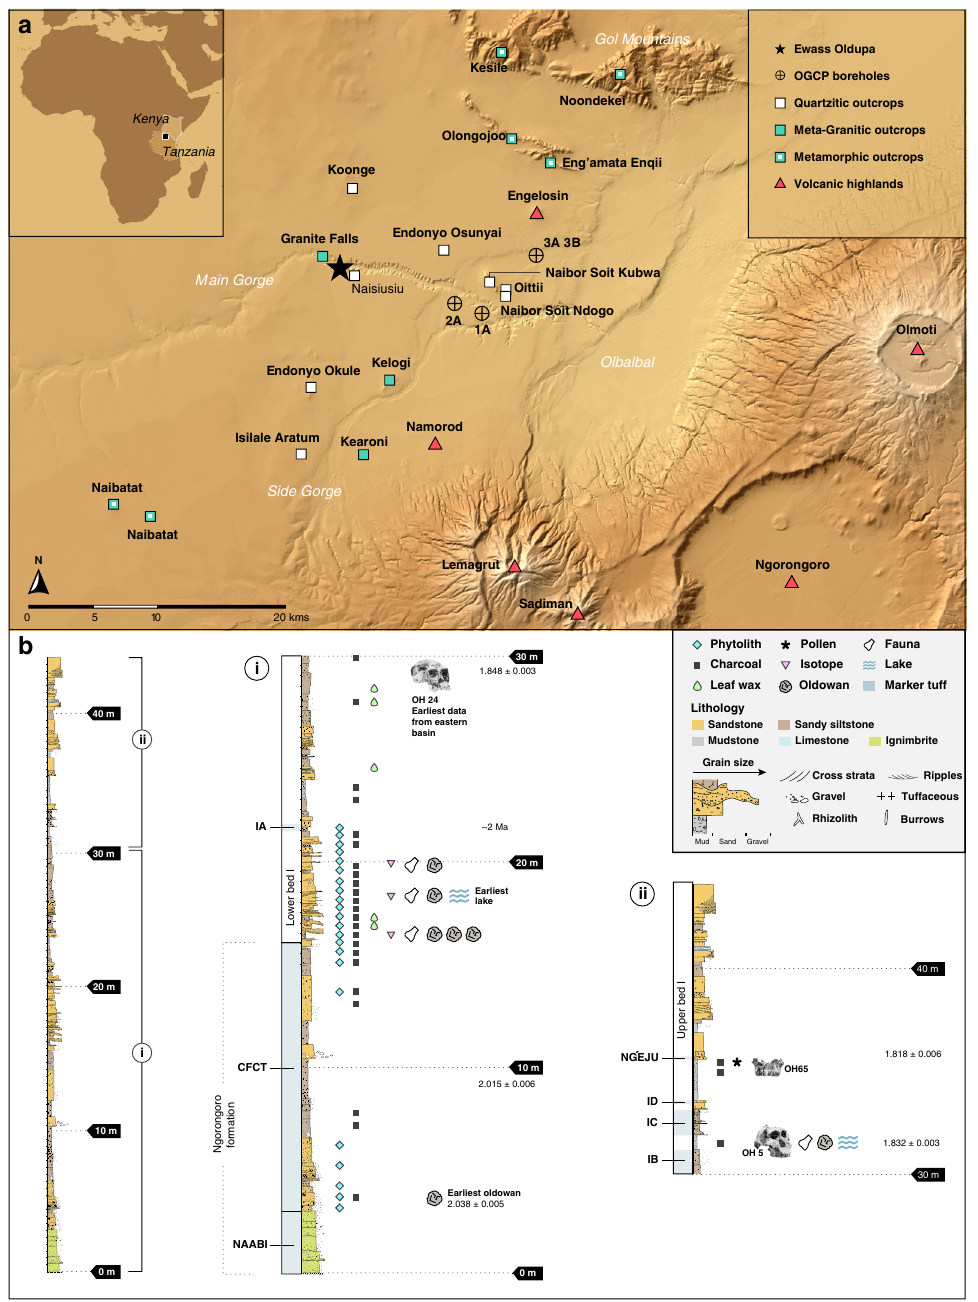
Fig. 1 Geographic and Stratigraphic Context. a Location map. Star symbol is for the site of Ewass Oldupa. Boreholes recently published 18 are shown for reference. Major rock types potentially available for hominin exploitation throughout the region are also marked. b Single stratigraphic section from Ewass Oldupa, subdivided into two segments: lower (i) and upper (ii). Ngorongoro formation: the succession starts with the Naabi, a green-gray, quartz-trachyte welded tuff dated to 2.038 ± 0.005 Ma 25 . A thin red diamictite overlies the Naabi and separates it from a series of fi ning-upward sandstone-dominated units composed of ma fi c tephra (Fig. 2b) that is capped by siltstone. Ngorongoro formation, CFCT compositional zone: the strata are composed of reddish- brown sandstone, volcanic detritus, and tephra/siliciclastic diamictite 28 . (i) Lower Bed I — six units that upward fi ne from pebble-cobble conglomerate to cross-strati fi ed sandstone are attributed to meandering river channels, below Tuff IA. Subsequently, a fi ne-grained silty sandstone that fi nes into waxy, green-brown claystone with carbonate nodules was deposited in a lake setting. Lastly, interbedded sandstone, siltstone, claystone, and tuffaceous beds record fl uctuating environments from lacustrine to shallow lakeshore to fl oodplain with small fl uvial channels. (ii) Upper Bed I — starts with Tuff IB, overlying waxy, green-brown claystone (Fig. 2H), and then Tuff IC. Capping the succession is a beige, weakly strati fi ed sandstone that is geochemically consistent with Tuff 1D 22,25,26 . Above this, the Ng ’ eju Tuff is encountered in a succession of fi ne-grained fl oodplain deposits. Additional stratigraphic information is presented in Fig.